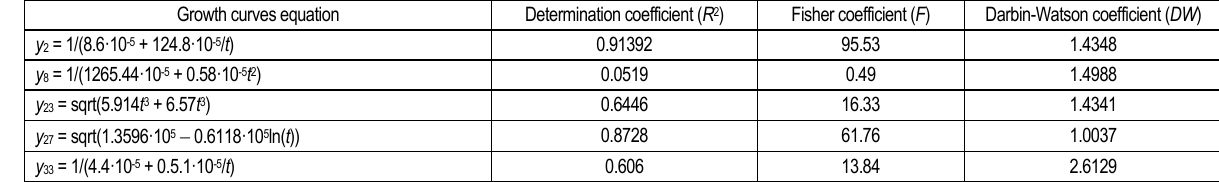
Table 9. Growth curves equations of socioeconomic development indexes of